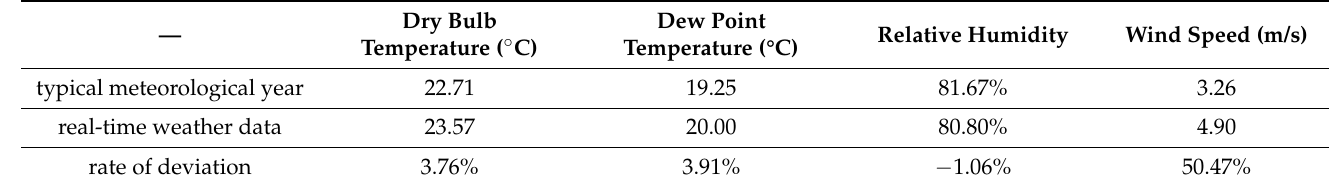
Table 4. Meteorological comparison of actual meteorological year and typical meteorological